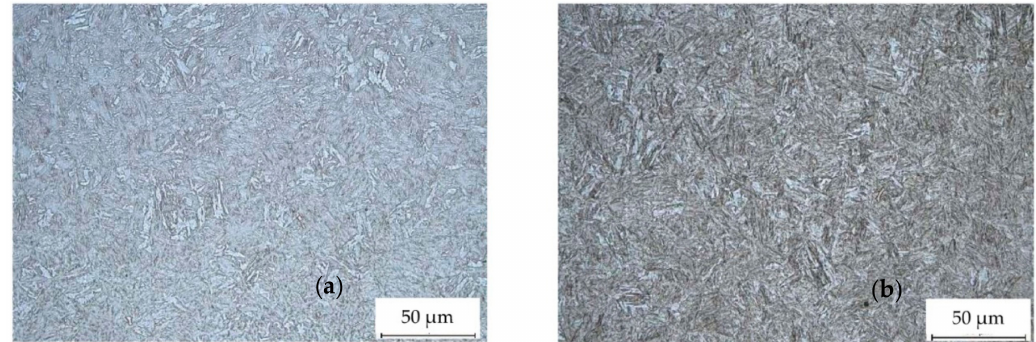
Figure 4. Microstructure of the 30PM steel: ( a ) frontal surface; ( b ) cross-section. Hardness measurements were carried out with the use of a Brinell machine, both par- allel and perpendicular to the rolling direction (EN ISO 6506-1). Before the measurements, the surfaces of the plate were polished. Impact strength of ARMSTAL 30PM was tested according to well-known Charpy method (EN 10 045-1). Tests were carried out for the samples with U- and V- shape notches at temperatures of +20 ◦ C and − 40 ◦ C, respectively. The geometry of the samples is presented in Figure 5. The results of ARMSTAL 30PM hardness measurements and impact strength tests are shown in Table 3.